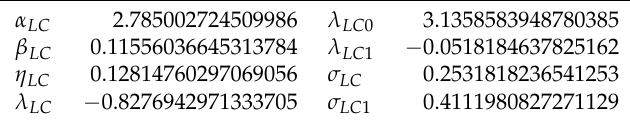
Table 1. Lorenz curve parameters obtained for Equation (9) by the